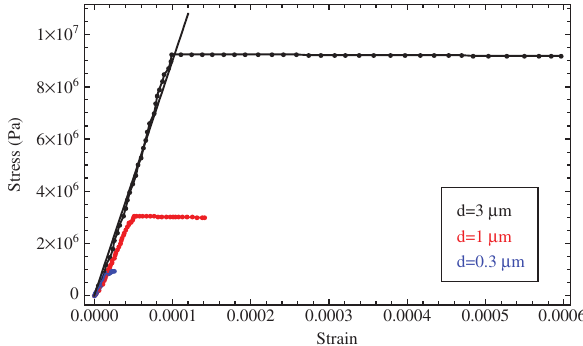
Figure 7: Recalculated engineering stress-strain graphs during Zr-based metallic glass micropillar compression using Eq. (3). The slope of the straight line provides a modulus value of 90